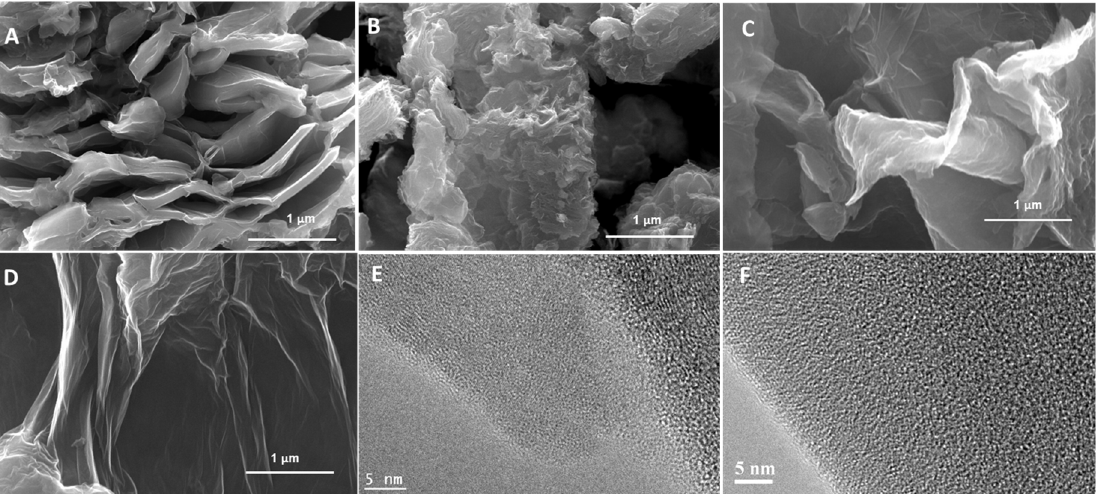
Figure 2. ( A ) Field emission scanning electron microscopy images of GIC before expansion, ( B ) EPG, ( C ) EGO, and ( D ) CGO. Transmission electron microscopic images of ( E ) EGO and ( F ) CGO.